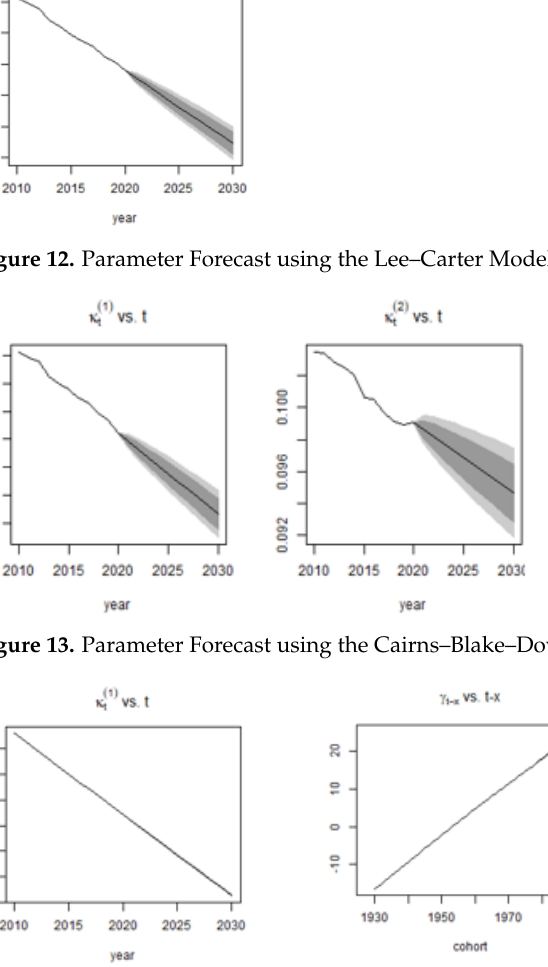
Figure 14. Parameter Forecast using the Renshaw–Haberman Model.